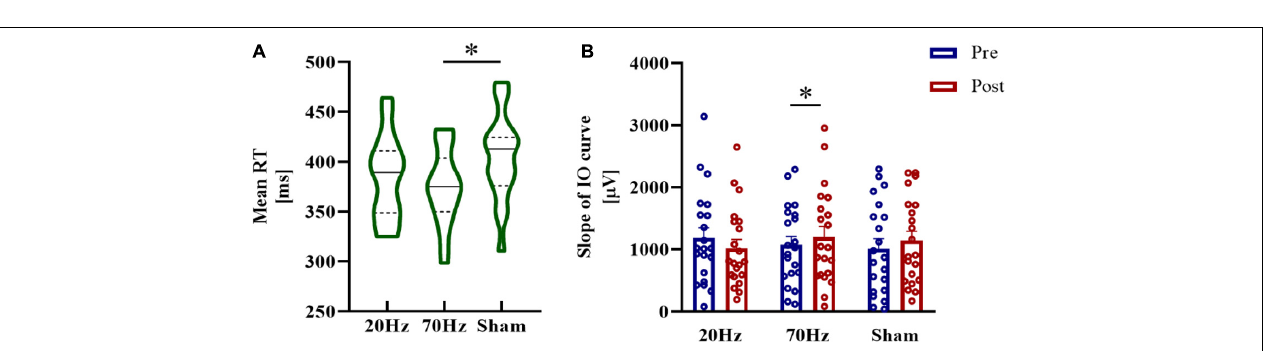
FIGURE 2 | Montage of TI stimulation and the generated electric field on a human head model. (A) The stimulation electrodes were located 30 mm away from the TMS hotspot, along the axis of the Fpz-Oz and T3-T4 in the EEG international 10–20 system. (B) The distribution of the envelope amplitude along the chosen direction (pointing posterolaterally at a 45 ◦ from the mid-line) in the brain. (C) An actual scene of electrode placement. The electrodes in red and green constitute channel1 and the electrodes in black and white constitute channel2. The ground electrode (brown) located on the mastoid behind the participant’s left ear to avoid current accumulations due to safety considerations.